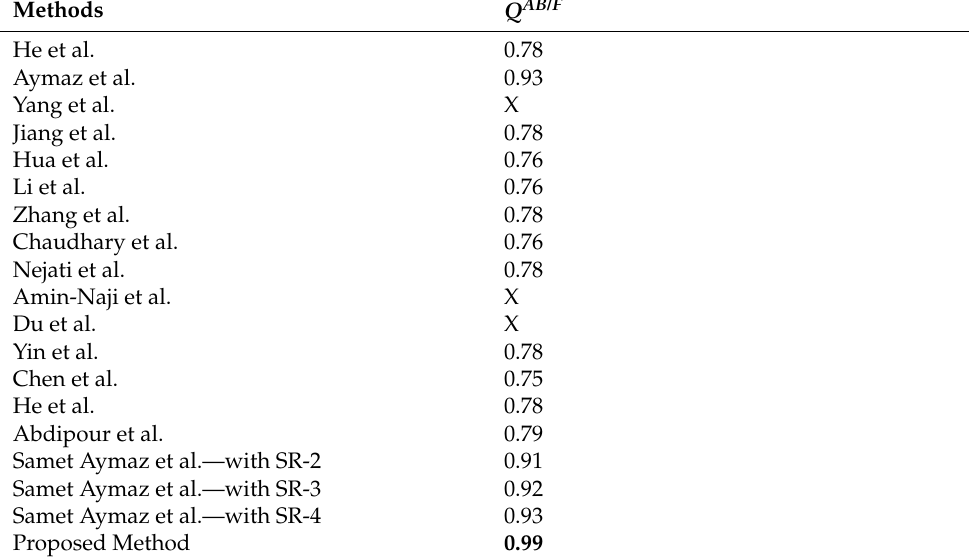
Table 36. The outcomes for the Pepsi image and comparisons with existing techniques in the litera- ture ([30]).